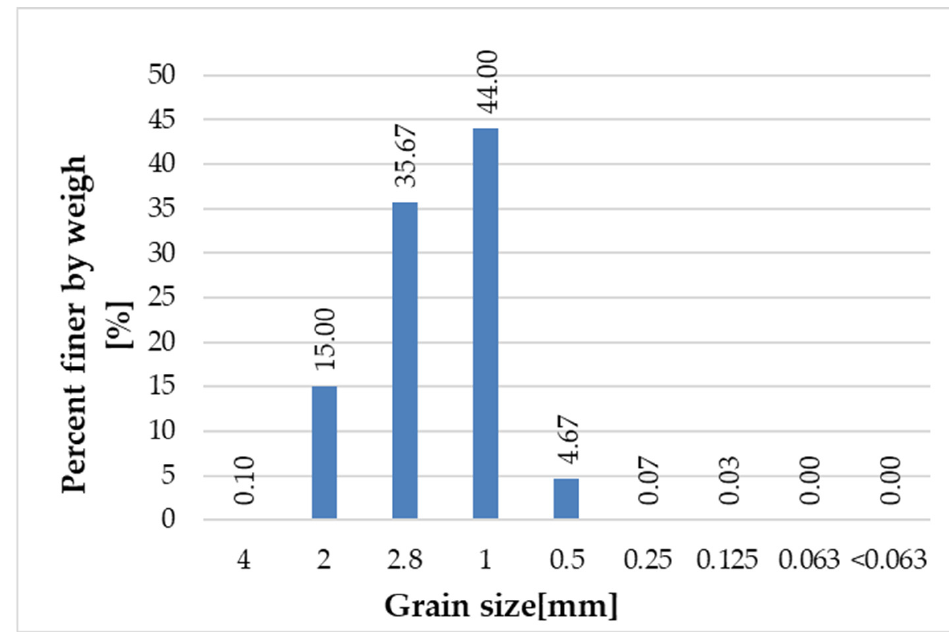
Figure 6. Grain size representation of recycled glass fraction 0.5/1 mm.